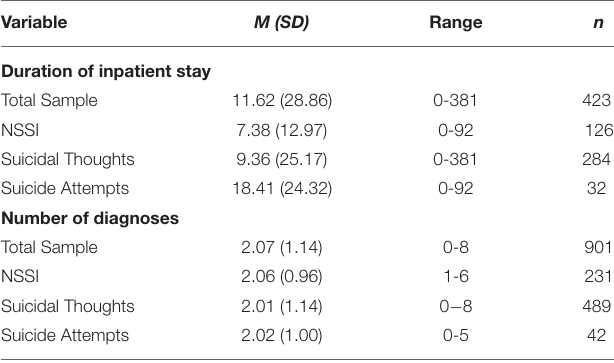
TABLE 2 | Description of total sample and subsamples for duration of inpatient stay and number of psychiatric diagnoses according to